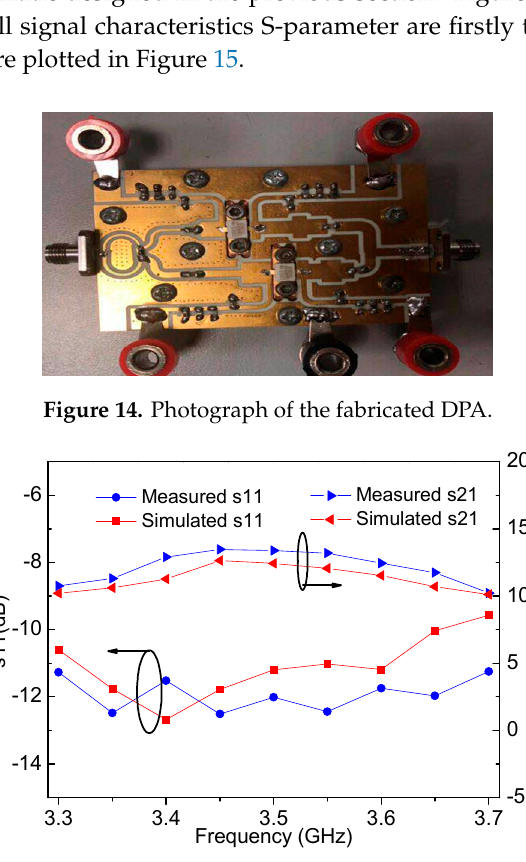
Figure 15. Simulated and measured small-signal frequency responses of the designed DPA.